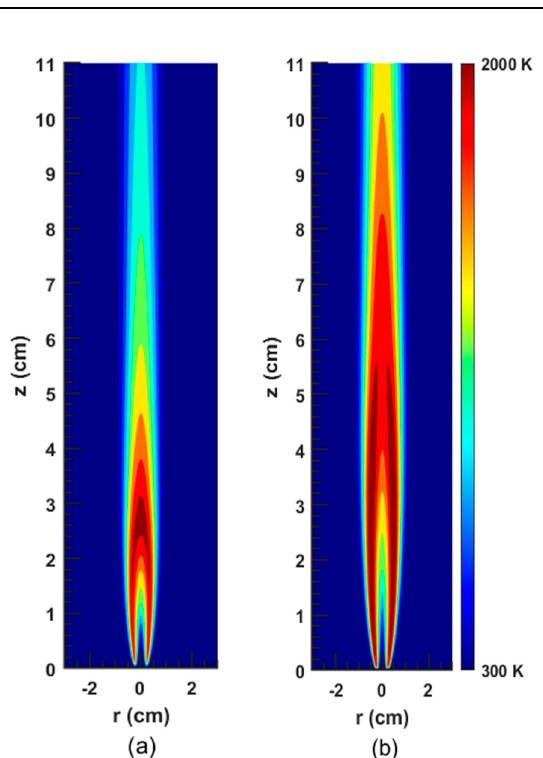
Figure 5. 2D contour plots of the temperature for the flames: ( a ) SM32; ( b ) SM80; obtained from the CoFlame code.